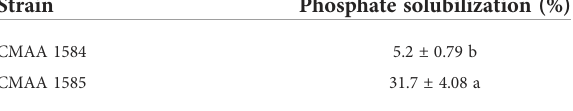
TABLE 1 Phosphate solubilization by Trichoderma asperelloides CMAA 1584 and Trichoderma lentiforme CMAA 1585. Strain